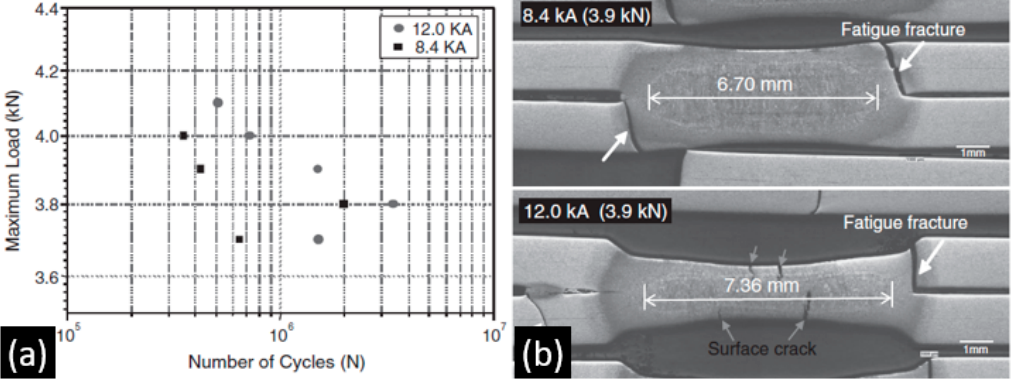
Figure 14. Mean lap shear strength for each material, coated and uncoated. Reprinted from [101], with permission of Taylor and Francis, 2019, http://www.tandfonline.com.